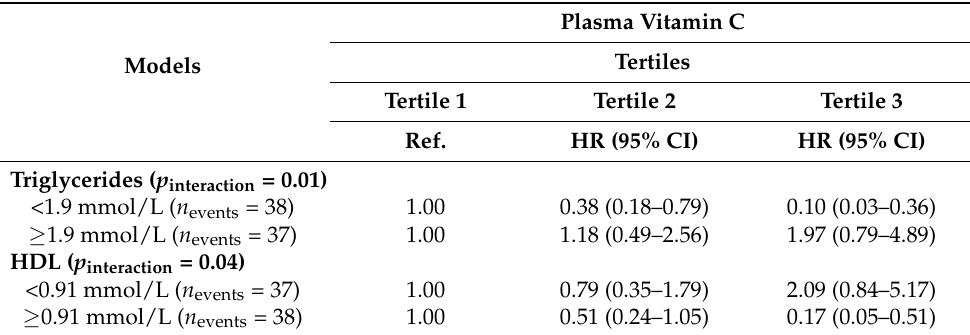
Table 3. Stratified prospective analyses of the association of plasma vitamin C with risk of graft failure.